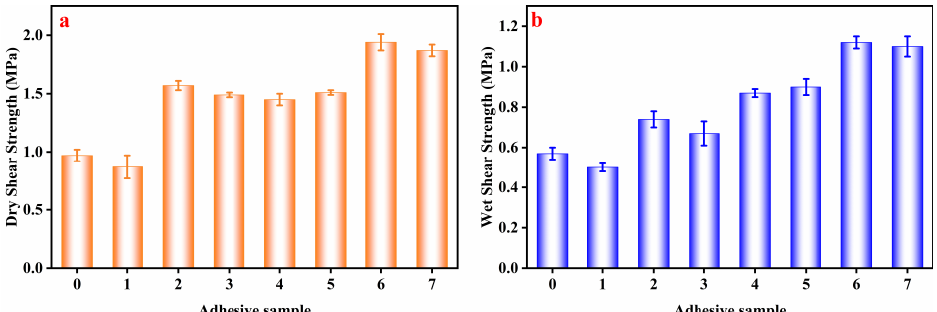
Figure 3. The ( a ) dry shear strength and ( b ) wet shear strength of different adhesive samples: (0) HPM adhesive, (1) HPM-papain adhesive, (2) HPM-sodium dodecyl sulfate (SDS) adhesive, (3) HPM-urea adhesive, (4) HPM-PAE adhesive, (5) HPM-papain-PAE adhesive, (6) HPM-SDS-PAE adhesive, (7) HPM-urea-PAE adhesive.